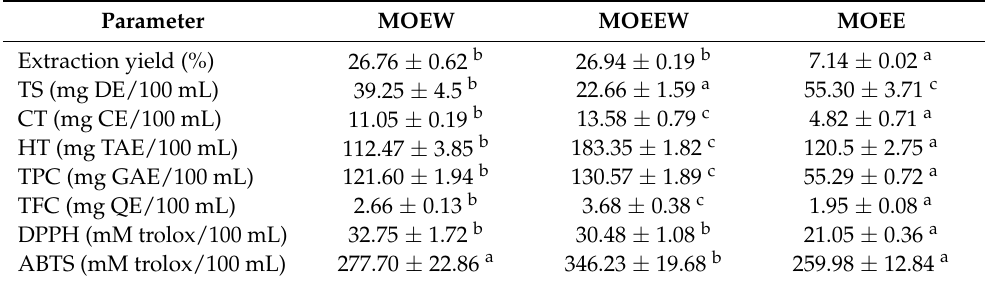
Table 3. Bioactive compounds content and antioxidant activity of M. oleifera